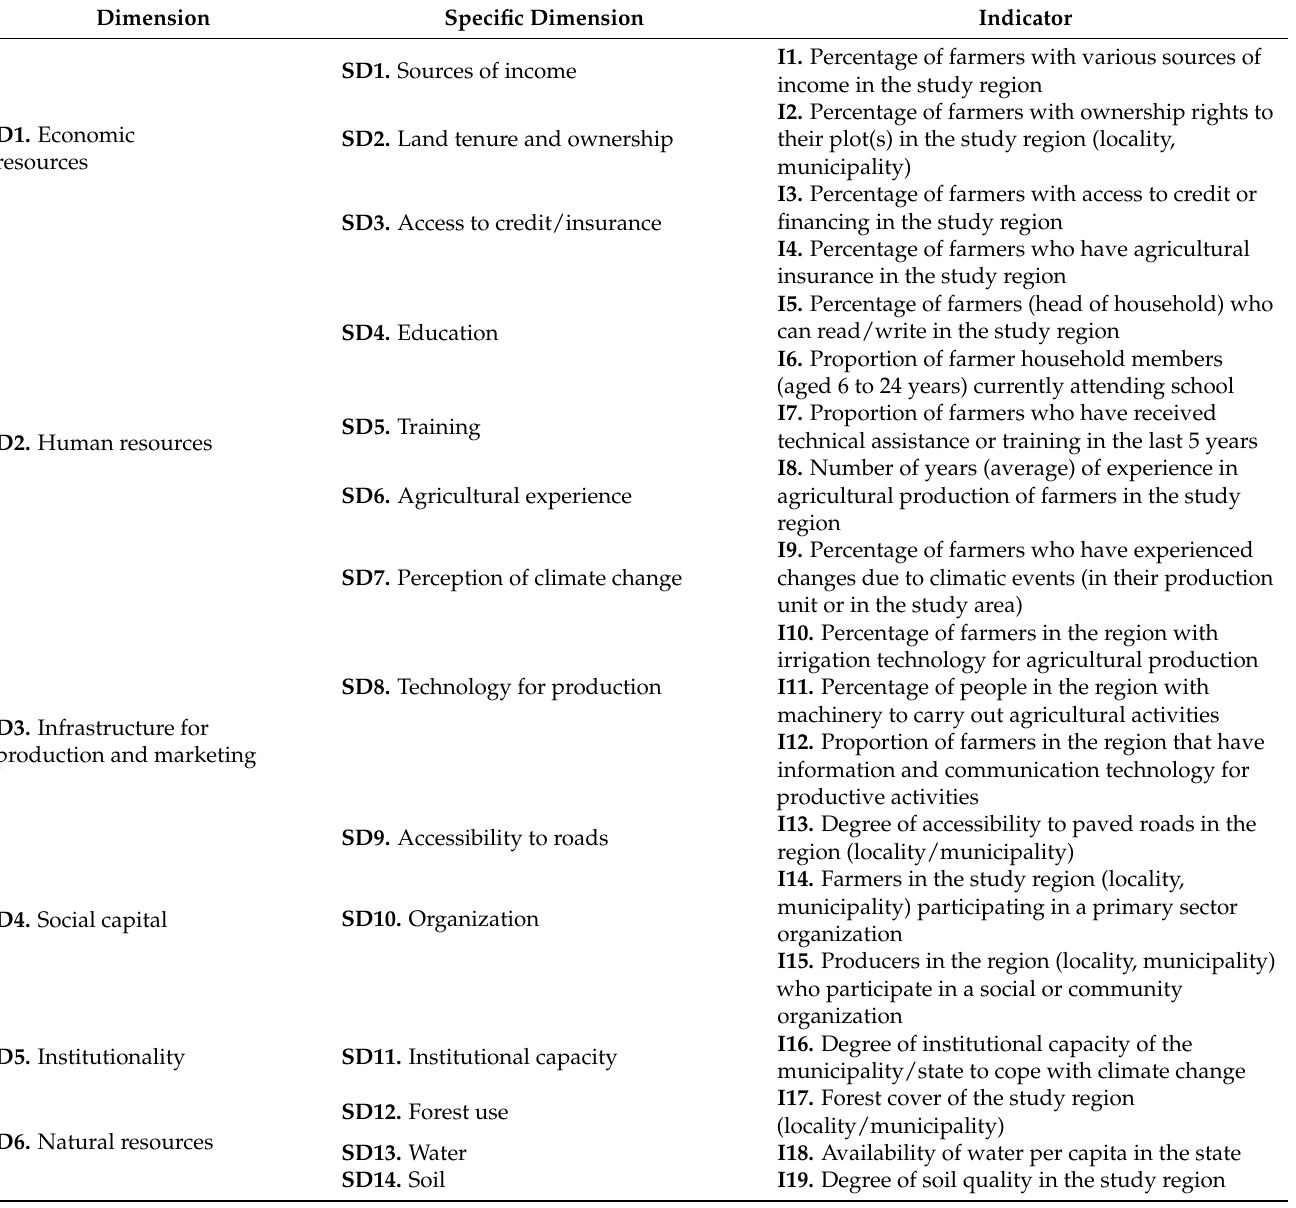
Table 3. Proposed indicators for assessing adaptive capacity to climate change. Specific